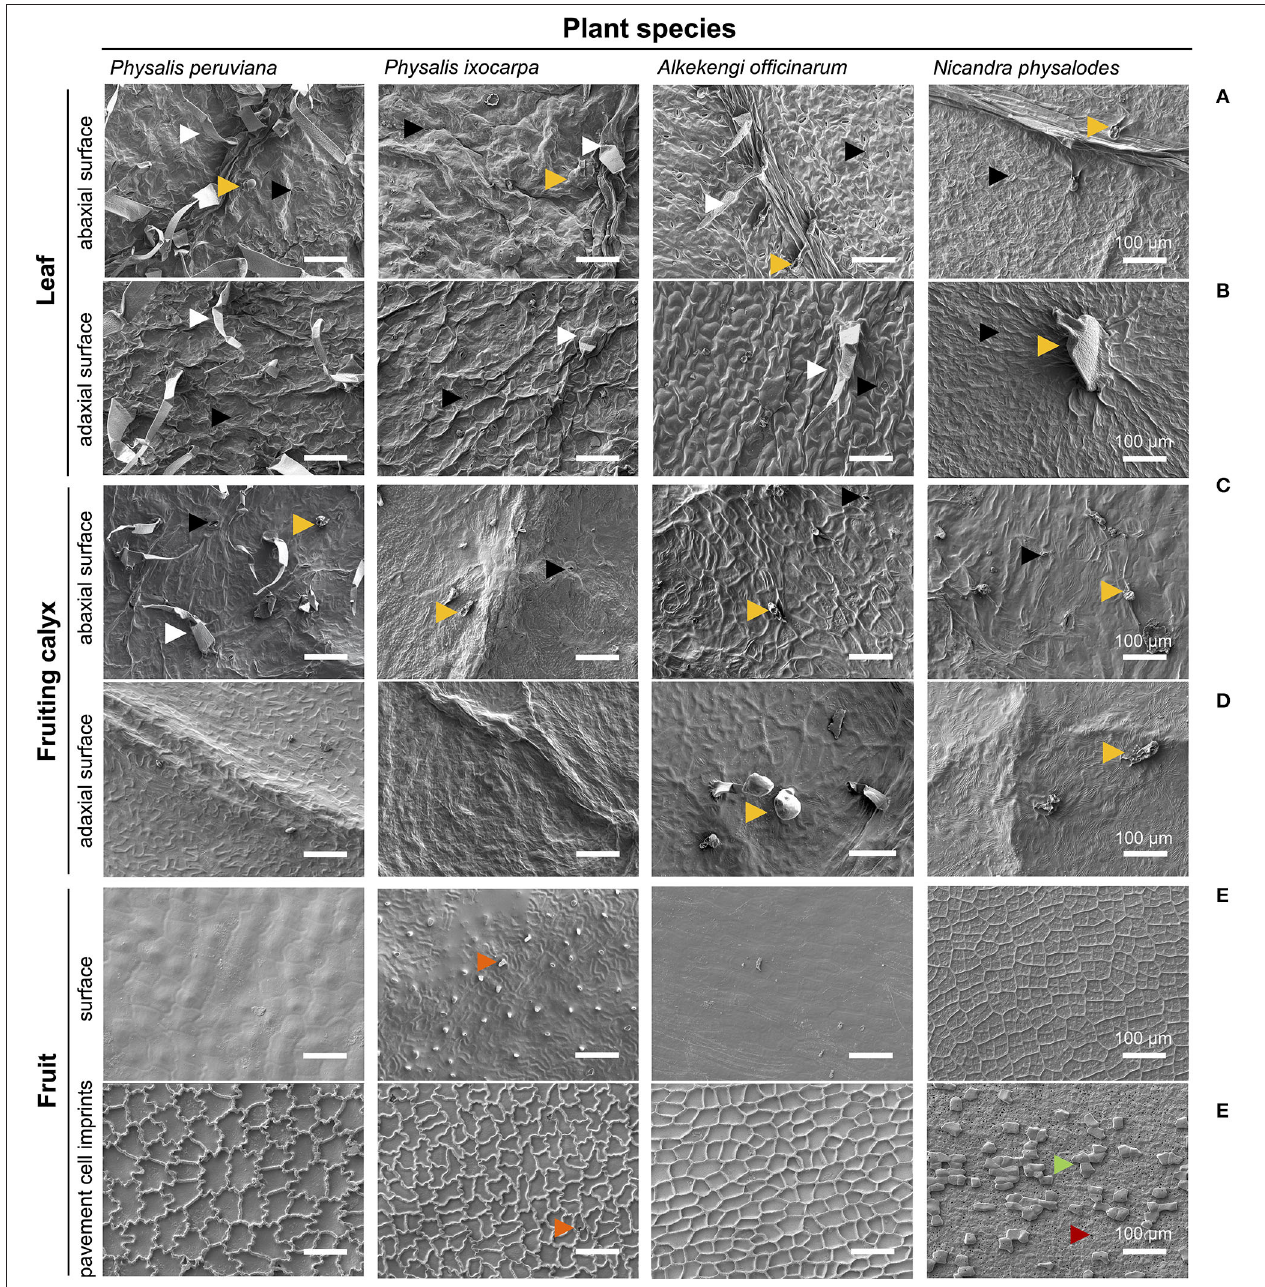
FIGURE 2 | Micromorphological characteristics of the leaf (A,B) , the fruiting calyx (C,D) , and the fruit surface (E,F) of Physalis , Alkekengi , and Nicandra species. Scanning electron microscopy was utilized for examining the abaxial and adaxial sides of fully expanded leaves and fully inflated fruiting calyces. Using enzymatically isolated fruit cuticles, the surface of ripe fruits and, on its reverse side, imprints of pavement cells were scanned. Arrowheads indicate stomata (black), non-glandular trichomes (white), glandular trichomes (light orange), cuticular protuberances/invaginations (dark orange), sclerified cells (green), and epidermal pores (red).